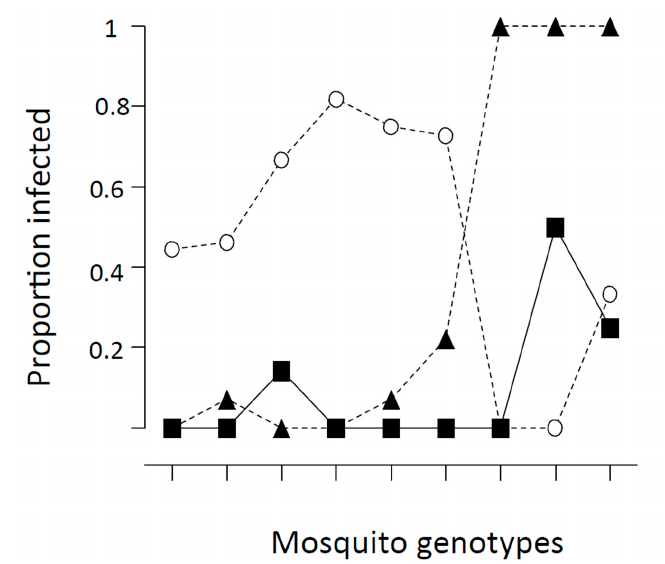
Figure 4. Proportion of Anopheles gambiae females infected after taking Plasmodium falciparum -infected blood meals. Three lines are for three different isolates of the parasite, nine ticks along the X-axis represents nine different families of the mosquito. From [30,34].